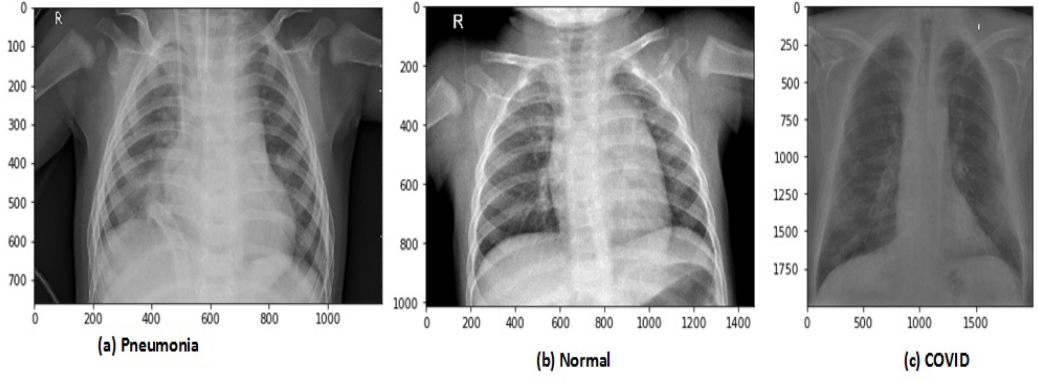
Figure 4. Types of chest X-ray images in CXI data